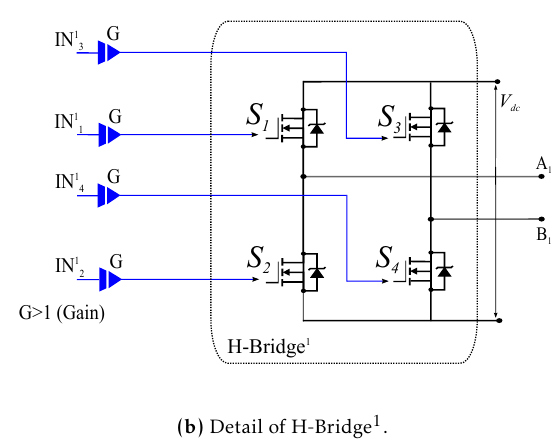
Figure 6. Cascaded H-bridge multilevel converter